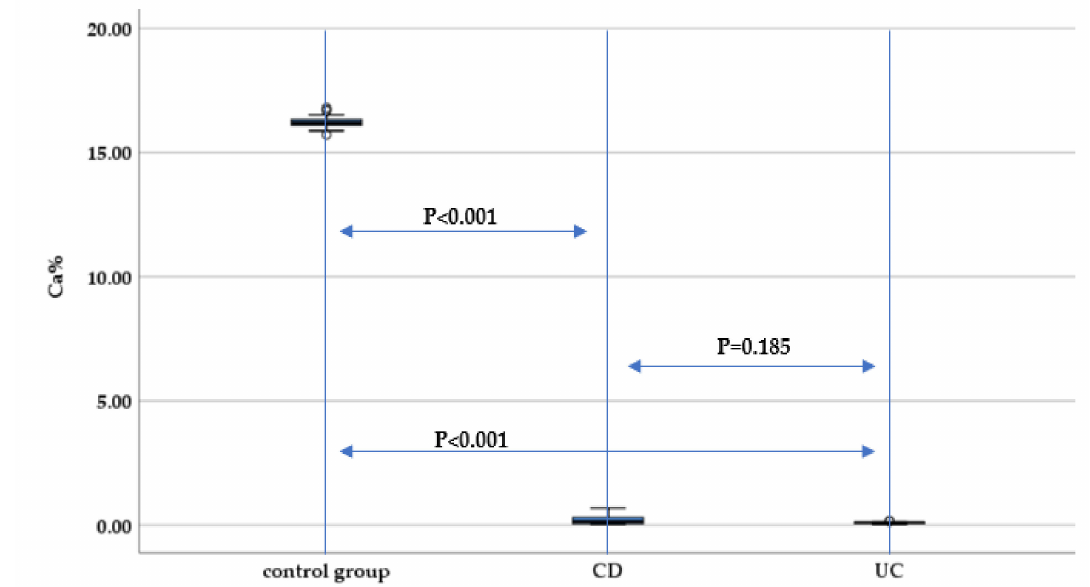
Figure 3. Evaluation of hair calcium concentration (Ca%) between IBD subtypes (UC and CD) and the control group. Hair manganese concentration was elevated in both the UC and CD group, compared to the control group, reaching statistically significant differences when comparing UC patients with the control group ( p = 0.003), and between the UC and CD group ( p = 0.009), but without statistical significance when comparing CD patients and the control group ( p = 0.81) (Figure 4).